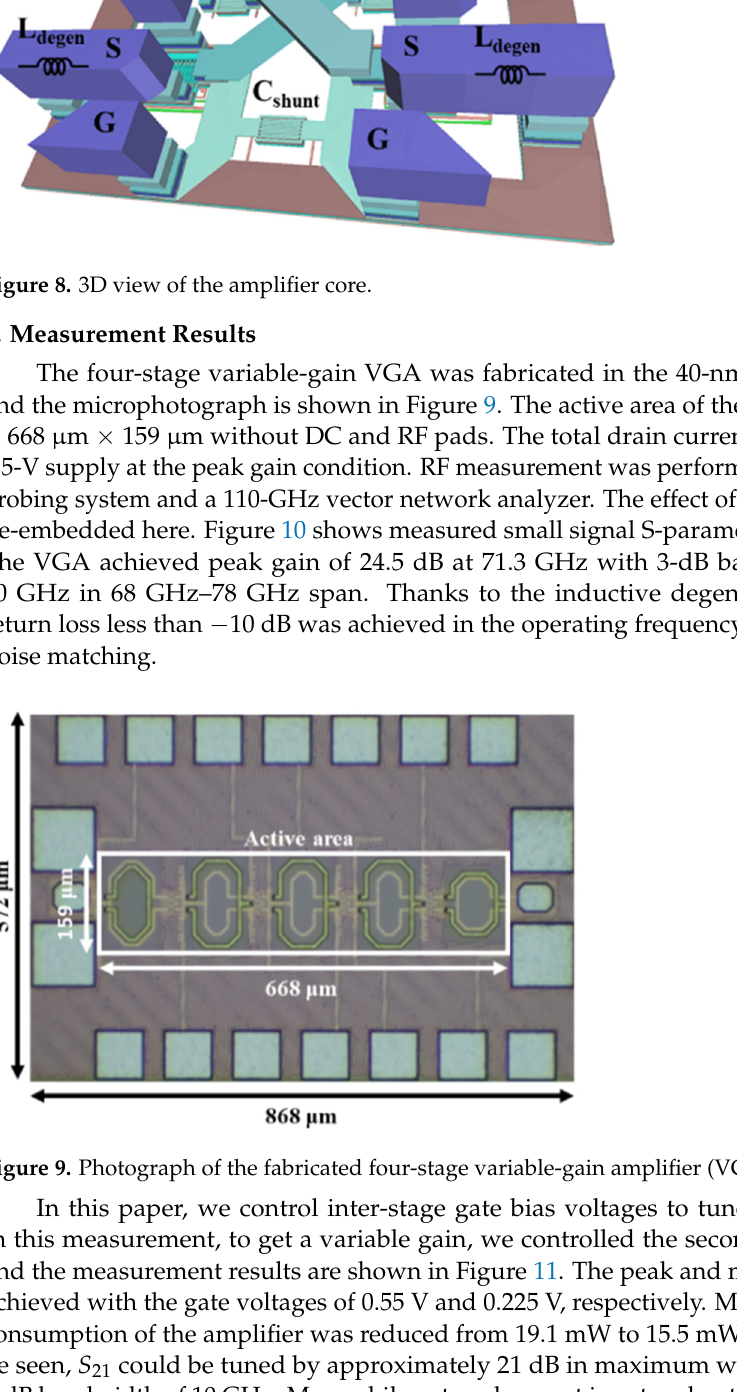
Figure 7. ( a ) A transformer-based impedance matching network. ( b ) A simple equivalent circuit of the matching network is presented by a half circuit for easy analysis. ( c ) The calculated secondary inductance according to coupling coefficient against C shunt at 73 GHz.